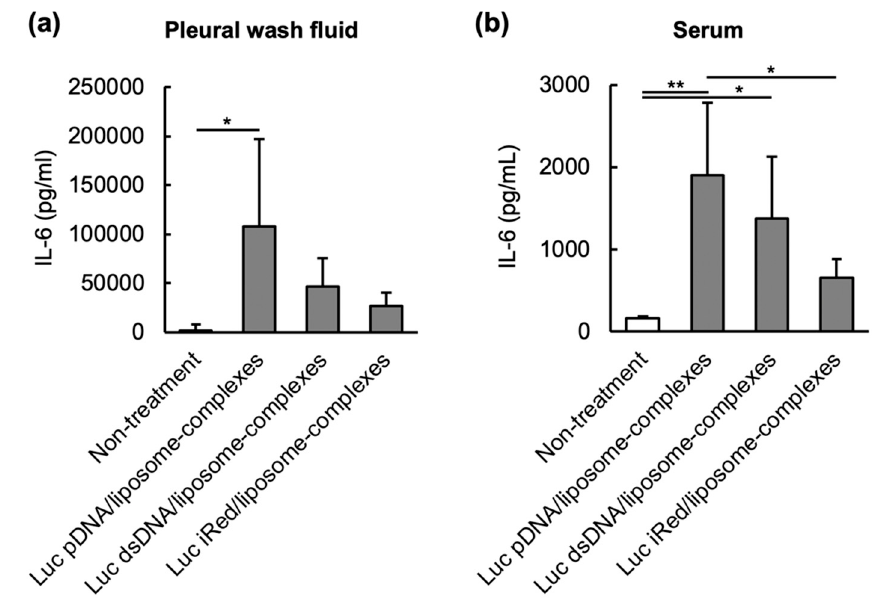
Figure 4. IL-6 production induced by different DNAs, formulated in DNA/liposome-complexes, injected intrapleurally. Orthotopic mesothelioma-bearing mice were intrapleurally injected with Luc pDNA/liposome-complexes, Luc dsDNA/liposome-complexes or Luc iRed/liposome-complexes (10 µg DNA/mouse) on day 7 after tumor cell inoculation. At 4 h post injection, IL-6 production level was measured in ( a ) pleural wash fluid and ( b ) serum. Data are reported as the mean ± SD ( n = 5). Significant differences are represented as * p < 0.05, ** p < 0.01.